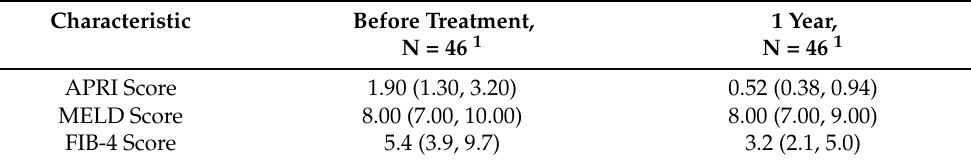
Table A2. Evolution of various liver scores before and after one year.